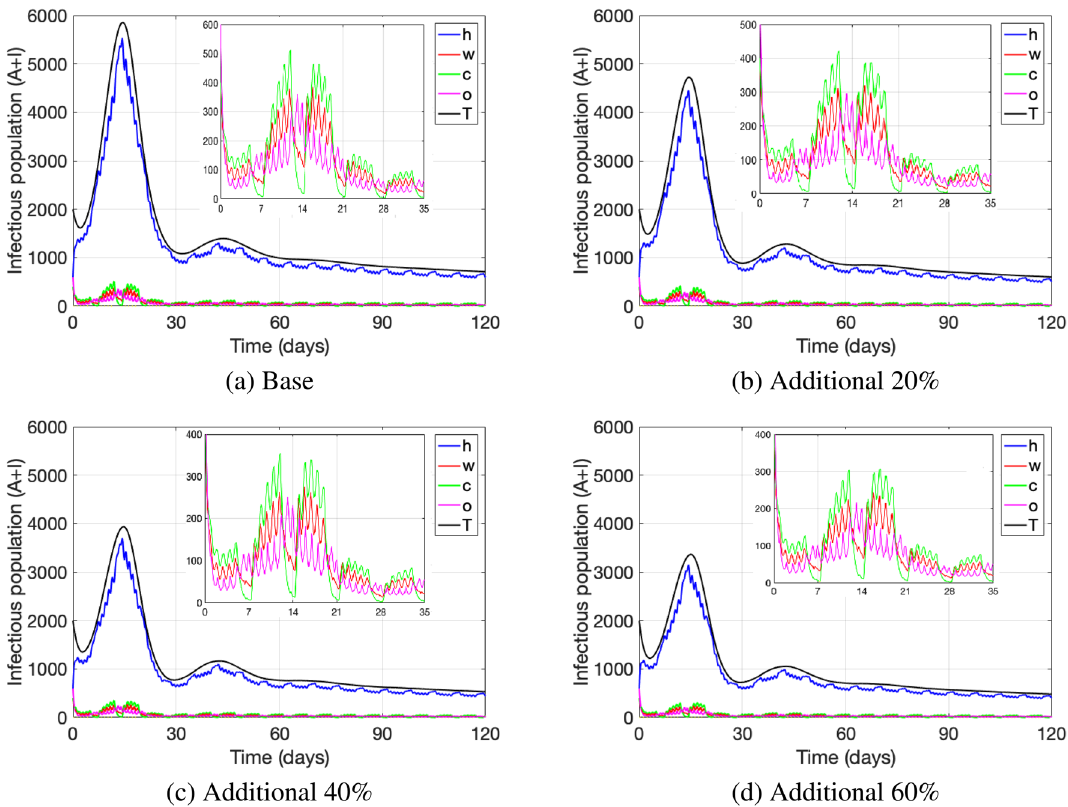
Figure 8. Addition (in percentage) to the transition rate leading to quarantine upon a close contact at every location. The parameter values used are as in Table